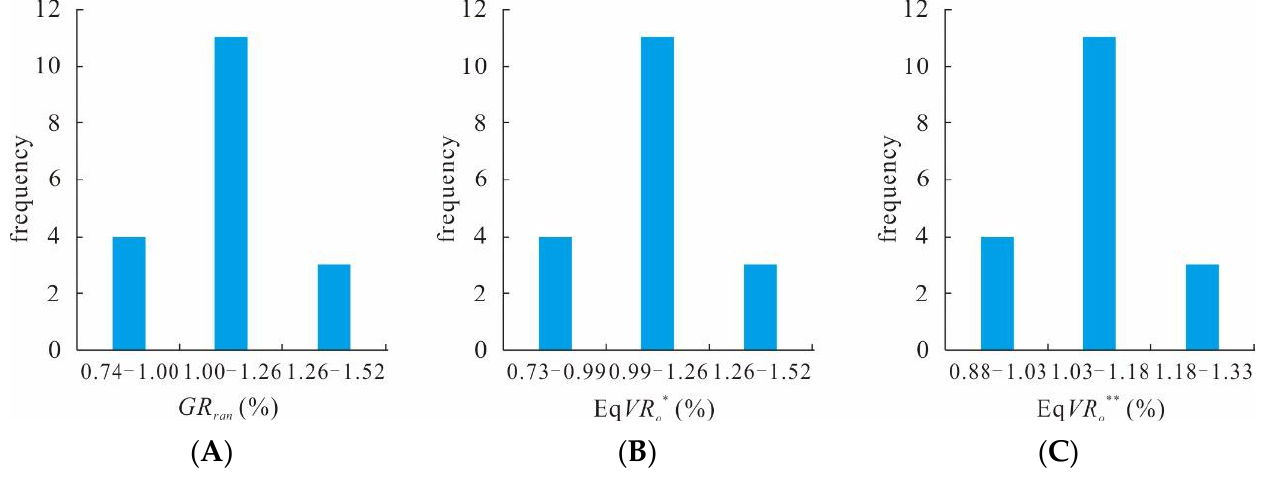
Figure 7. Random reflectance of graptolite and equivalent vitrinite reflectance distribution. ( A ) ran- dom reflectance of graptolite; ( B ) equivalent vitrinite reflectance distribution (according to [44]); ( C ) equivalent vitrinite reflectance distribution (according to [60]).